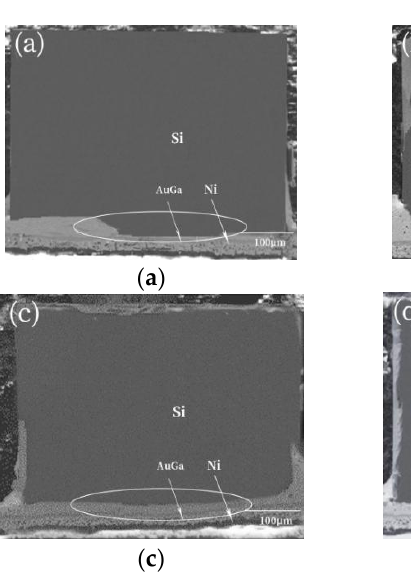
Figure 2. Photos of the samples at different soldering temperatures: 360 °C ( a ), 380 °C ( b ), 400 °C ( c ), 420 °C ( d ), and 440 °C ( e ).